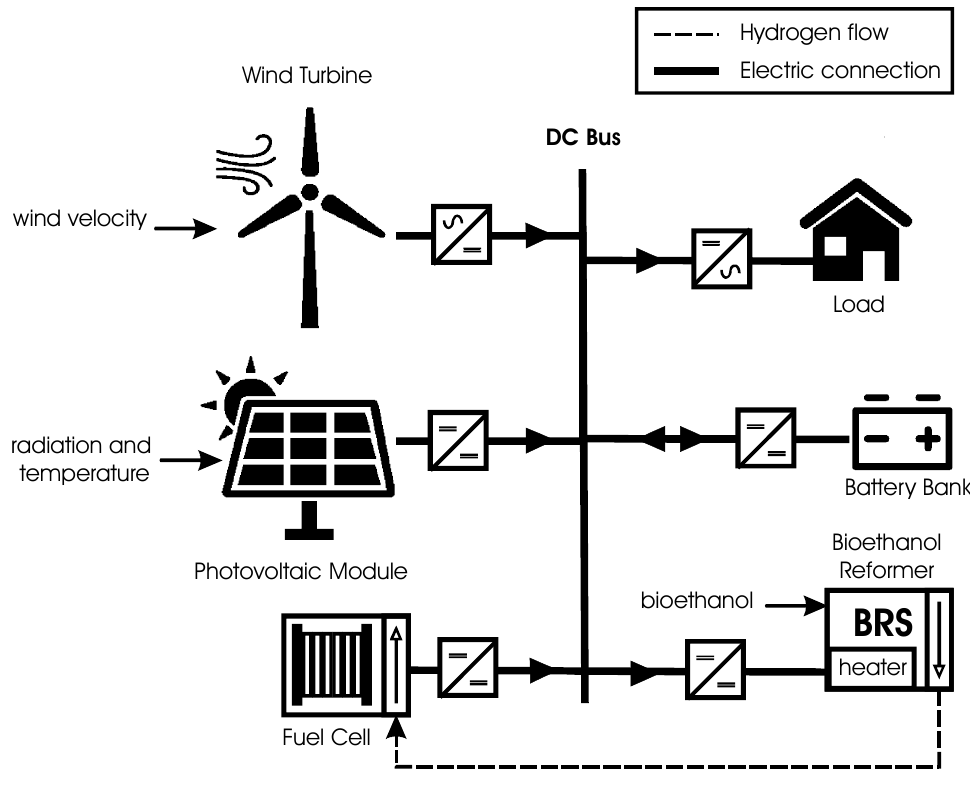
Figure 1. Schematic diagram of the isolated hybrid renewable energy system with hydrogen production from